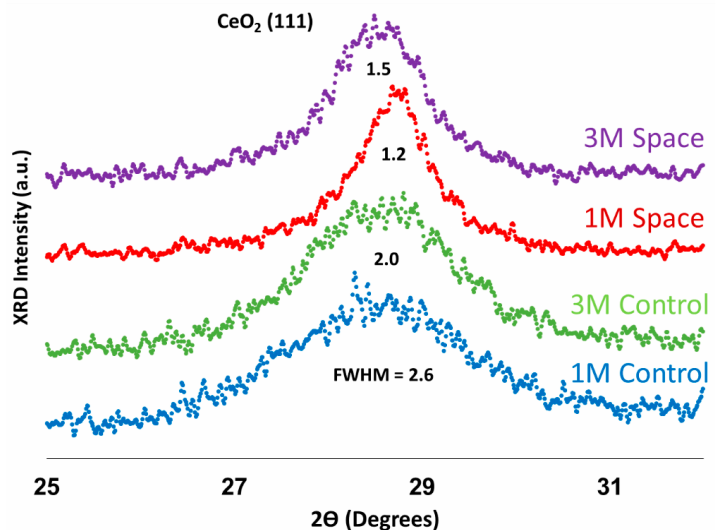
Figure 7. Comparison of FWHM of (111) plane for CeO 2 sample.